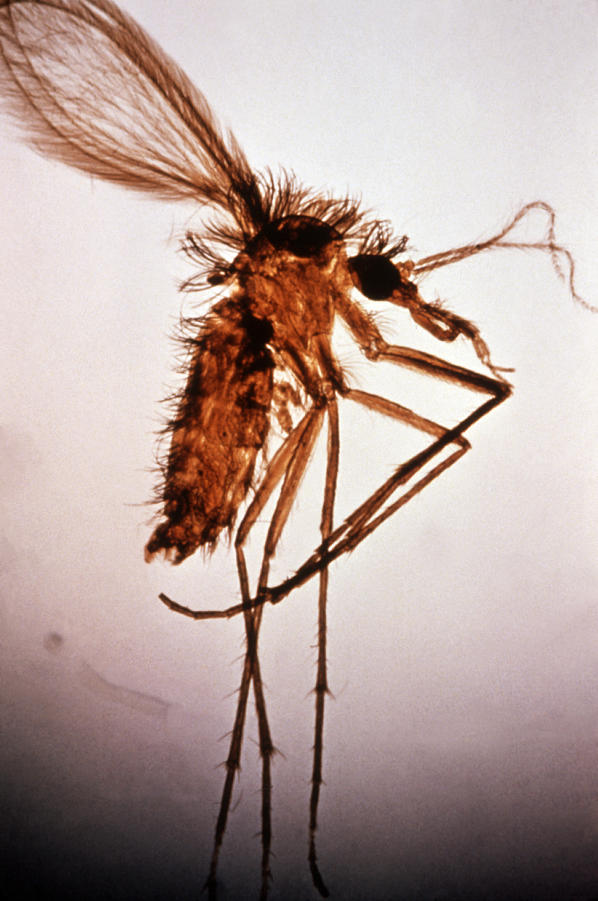
Female sandflies transmit the
Leishmania parasite